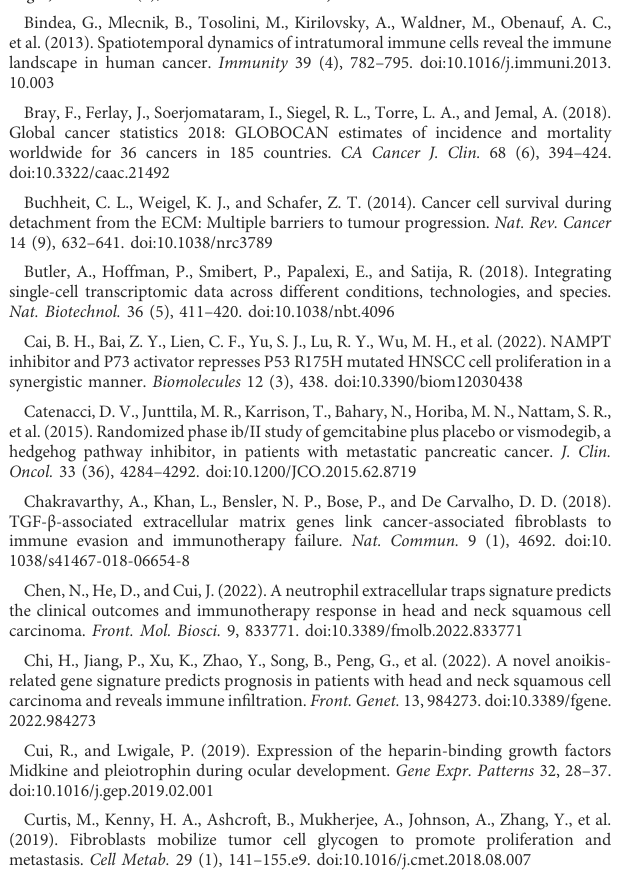
SUPPLEMENTARY FIGURE S1 (A – C) ThetabularformatsofclinicalsampleinformationofTCGA,GSE65858 and GSE41613 cohorts. SUPPLEMENTARY FIGURE S2 (A) The tumor mutation waterfall plot. (B) Tumor mutation burden (TMB) in the groups C1 and C2 from TCGA database, p = 0.22. SUPPLEMENTARY FIGURE S3 (A – B) CafS distribution in the smoking and no smoking groups; TCGA ( p = 0.76) and GSE65858 ( p = 0.84). SUPPLEMENTARY FIGURE S4 (A – D) PGAM1 and ENO1 expression in normal nasopharyngeal epithelial cell line (NP69) and HNSCC cell lines (CAL-27 and FaDu), quantitative real-time PCR assay, * p < 0.05; ** p < 0.01; *** p < 0.001; **** p <